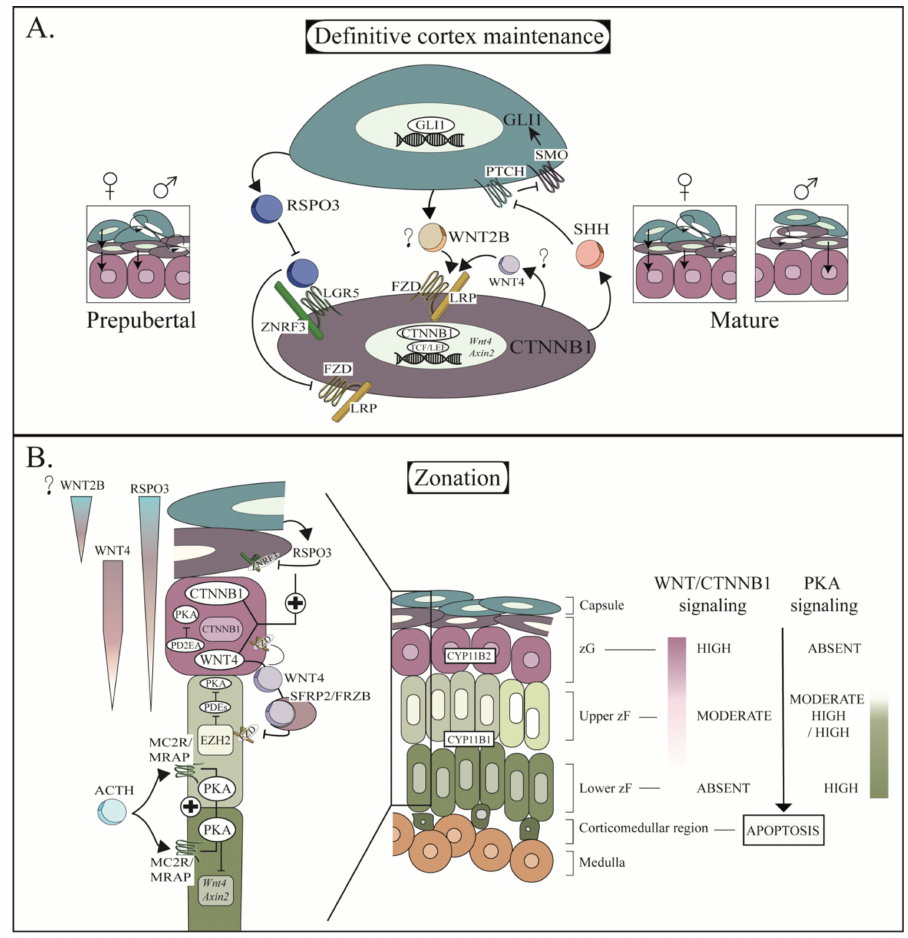
Figure 3. Development, maintenance, and establishment of zonation in the mice definitive adrenal cortex: ( A ) Schematics model for the definitive cortex maintenance. A WNT/SHH double-paracrine mechanism is needed to ensure proper development and maintenance of the adrenal cortex. Capsular stem cells regulate WNT pathway activation in the progenitor zG cells by secreting RSPO3, which in turn induces the clearance from the cell membrane of the WNT signaling inhibitor ZNRF3 and its subsequent degradation. This leads to an increase in canonical WNT signaling in the subcapsular progenitor and it promotes their proliferation (and subsequent differentiation into steroidogenic zG cells). Capsular WNT2B could be the main ligand responsible for the maintenance of the adrenal cortex (as WNT4 expressed in the zG appears to be more important for the differentiation of the steroidogenic zG cells). SHH secreted by the zG progenitor cells promotes the activation of GLI1 in the capsular stem cells and, consequently, their proliferation. Before puberty, both the capsular stem cells and subcapsular progenitor cells contribute to the maintenance of the adrenal cortex. After puberty, both the capsular stem cells and subcapsular progenitor cells contribute to the maintenance of the adrenal cortex in female. In male, only the subcapsular progenitor cells contribute to the maintenance of the adrenal cortex. ( B ) Schematics model for adrenal cortex zonation. Capsular and subcapsular WNTs and RSPO3 secretion create a gradient of WNT/CTNNB1 activity throughout the upper cortex. Elevated WNT/CTNNB1 activity drives steroidogenic zG cells differentiation and inhibits differentiation of zG cells into zF. PDE2A (whose transcription is positively regulated by CTNNB1) could be involved in the inhibition of PKA signaling in the zG by degrading cAMP. Moderate/low WNT/CTNNB1 favors the differentiation of zG cells into zF cells and the proliferation of zF cells. Binding of ACTH to its receptor promotes the activation of PKA signaling and antagonizes WNT signaling. Potential expression of FRZB or SFRP2 in the zF could also contribute to the inhibition of WNT signaling in the zF. PKA signaling is also optimized by adrenocortical cell programming by EZH2, which inhibits the transcription of Pde7b, Pde3a and Pde1b